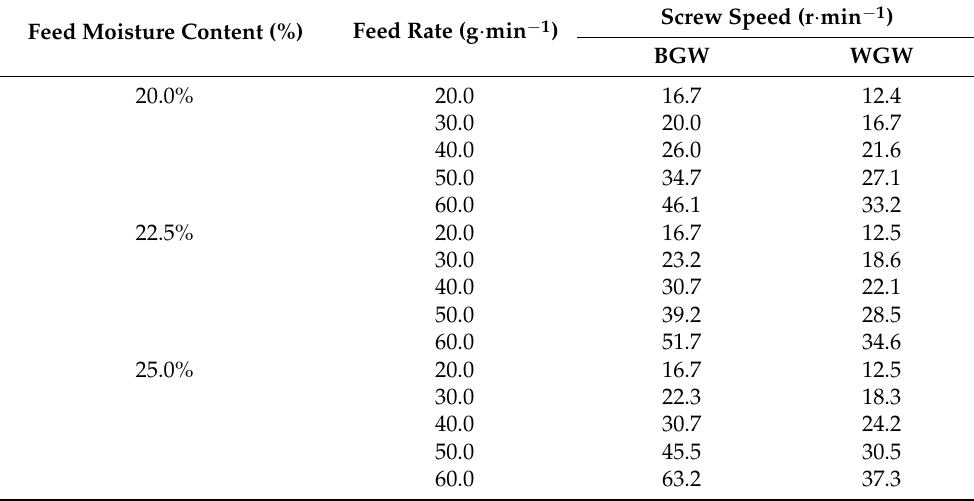
Table 3. Screw speed corresponding to feed moisture content and feeding rate. Feed Moisture Content